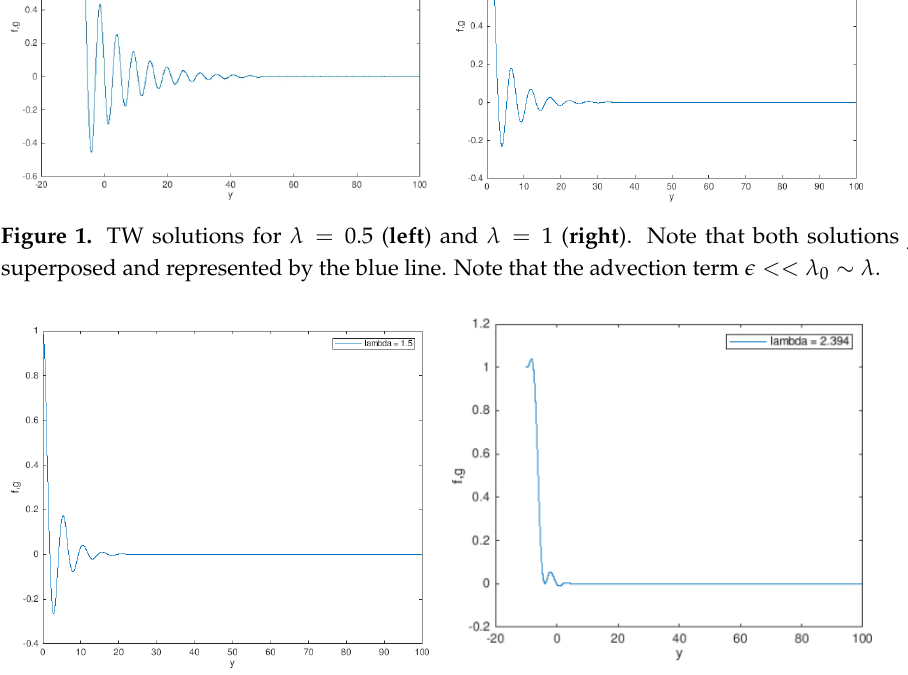
Figure 2. TW solutions for λ = 1.5 ( left ) and λ = 2.394 ( right ). Note that both solutions f , g are superposed and represented by the blue line. Note that the advection term (cid:101) << λ 0 ∼ λ